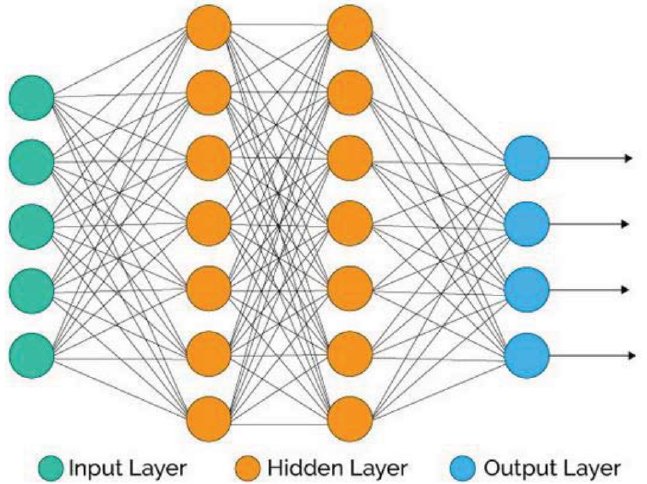
Figure 2. Artificial neural network architecture (adapted from Dastres and Soori